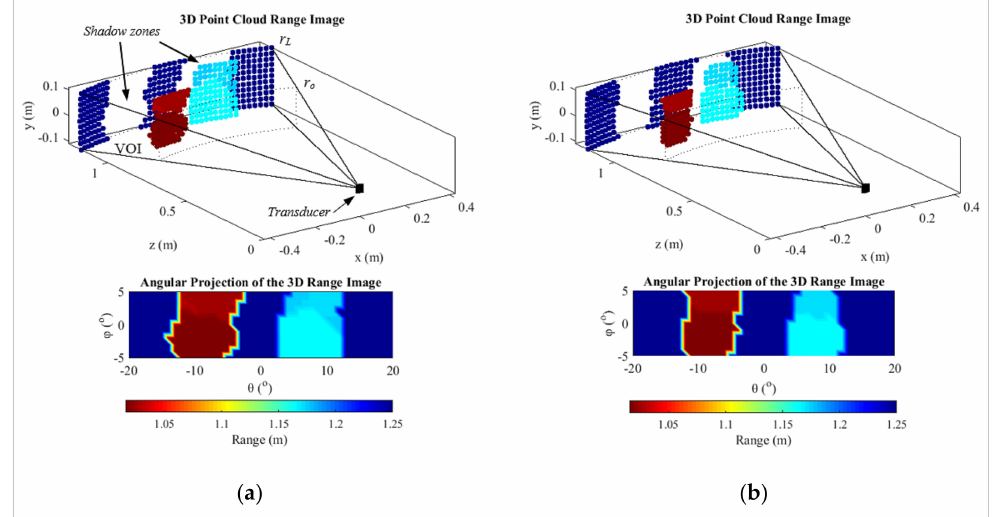
Figure 22. Images made from ( a ) a single ping of the element m = 2, n = 3 required a higher threshold level than that with ( b ) the TFM, − 20 dB, and − 30 dB, respectively. Furthermore, the objects were larger in the single ping image, decreasing the angular